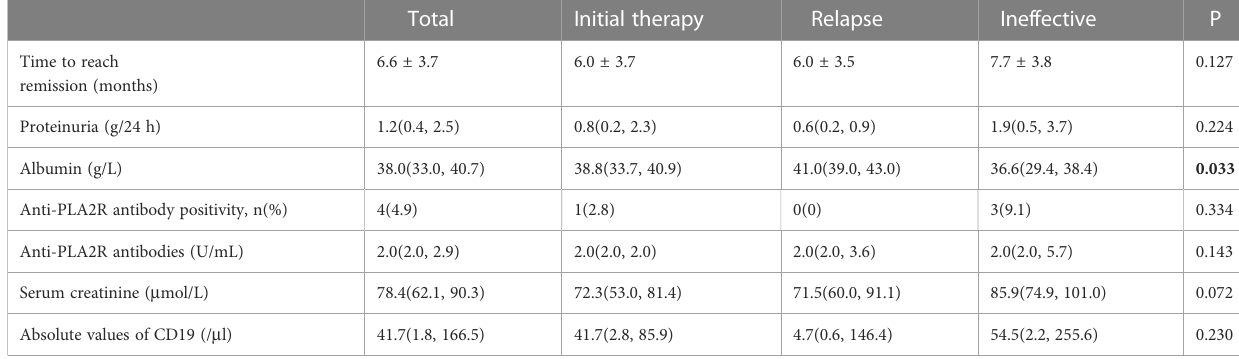
TABLE 3 Clinical characteristics of PMN patients after rituximab treatment for 12 months.